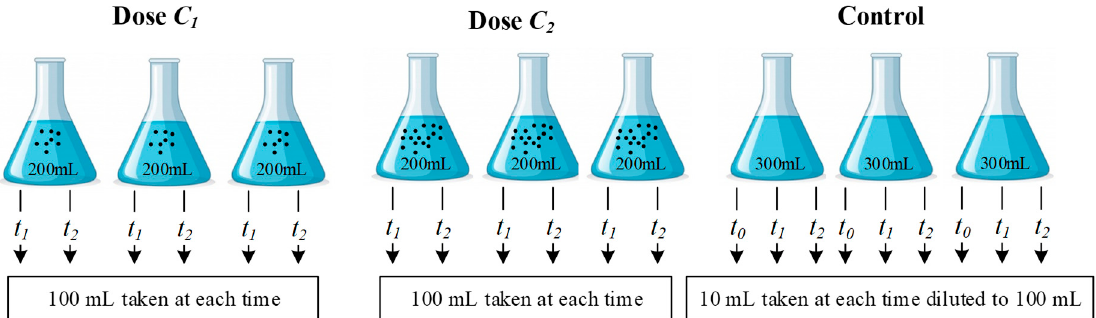
Figure 1. Schematic of antibacterial assessment procedure for a certain microorganism, nanoparticle type and water type.